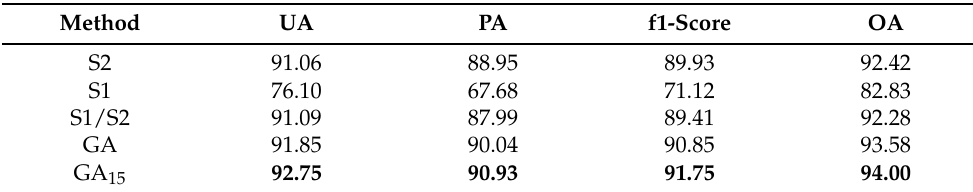
Table 3. Overall accuracy and macro average values of UA, PA, and f1-score of 5 different SVM classification models constructed based on the original dataset. With bold is highlighted the best model for each